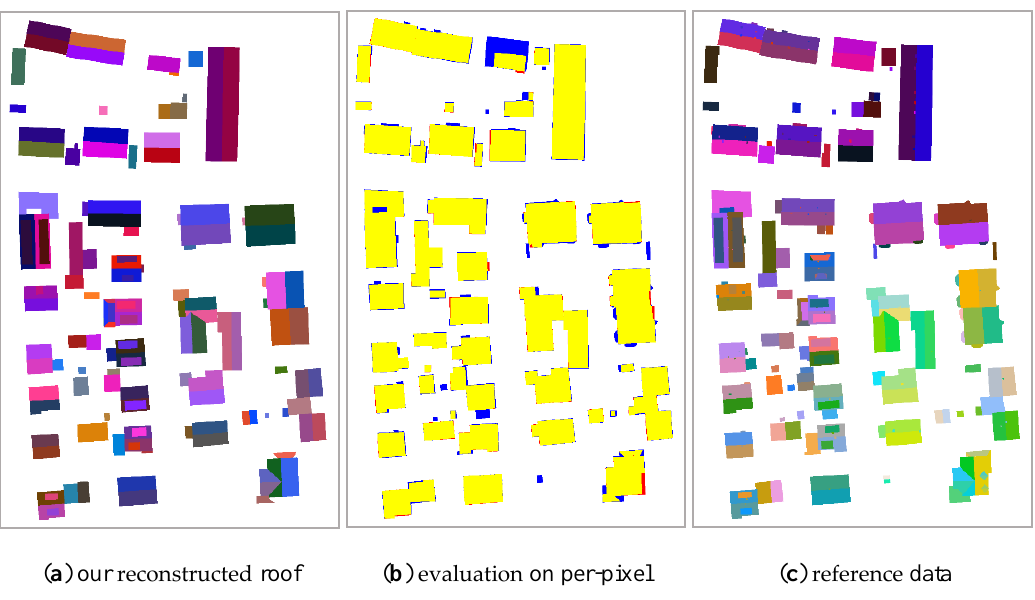
Figure 18. Evaluation of our reconstructed roof planes and reference data. 3D information is converted to a label image. In the middle column, the yellow color denotes true positive pixels (TP), the red color denotes false positive pixels (FP), and the blue color denotes false negative pixels (FN).